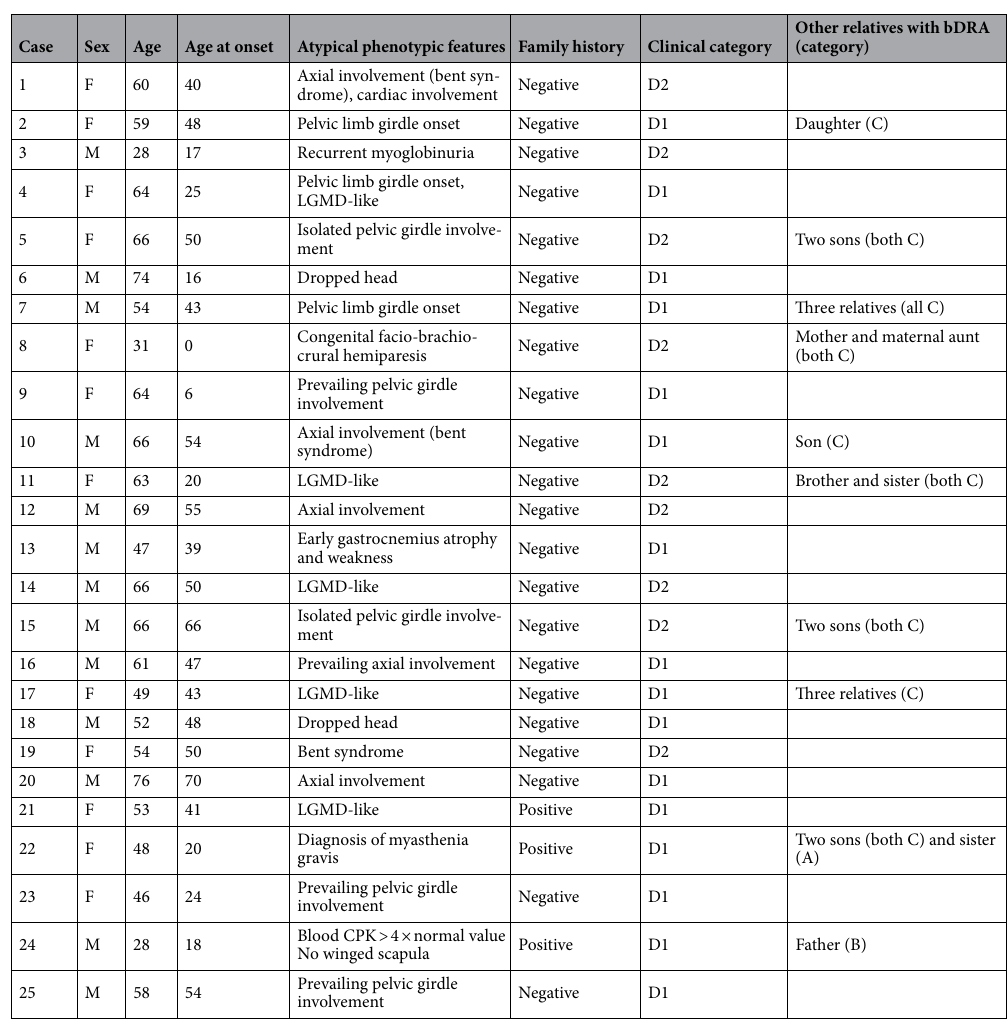
Table 3. Index cases with atypical clinical features (clinical category